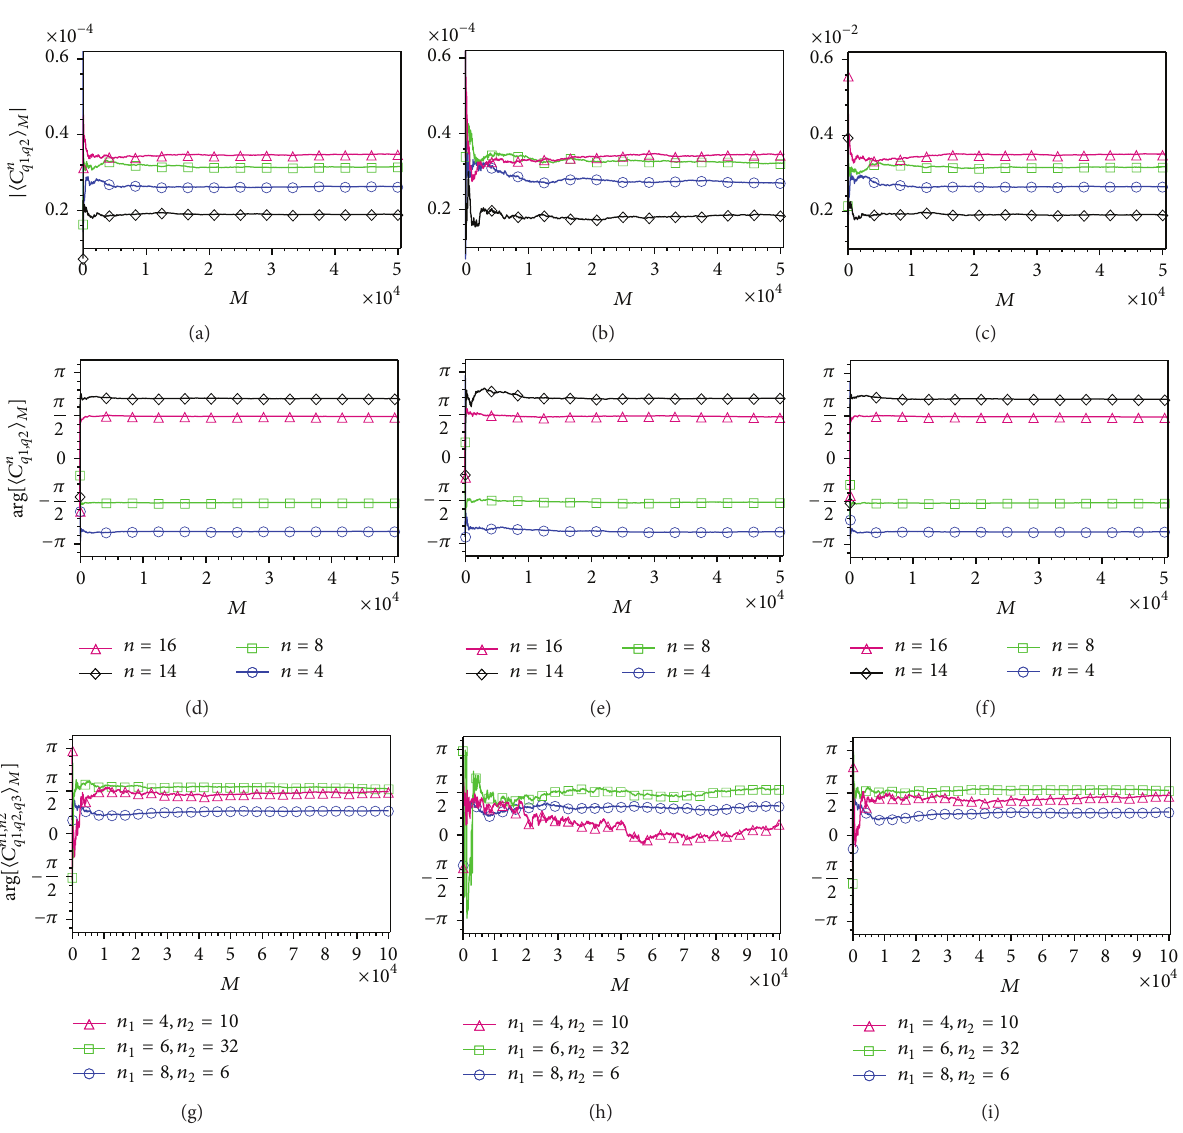
⟩ ] at 𝑞 = 0.25 nm −1 , 𝑞 = 0.09 nm −1 , 𝑛 = 1 2 𝑞 1 ,𝑞 2 𝑀 ⟩ ] at 𝑞 1 ,𝑞 2 ,𝑞 3 𝑀 𝑛 𝑀 . Simulations 1 and 2 as a function of